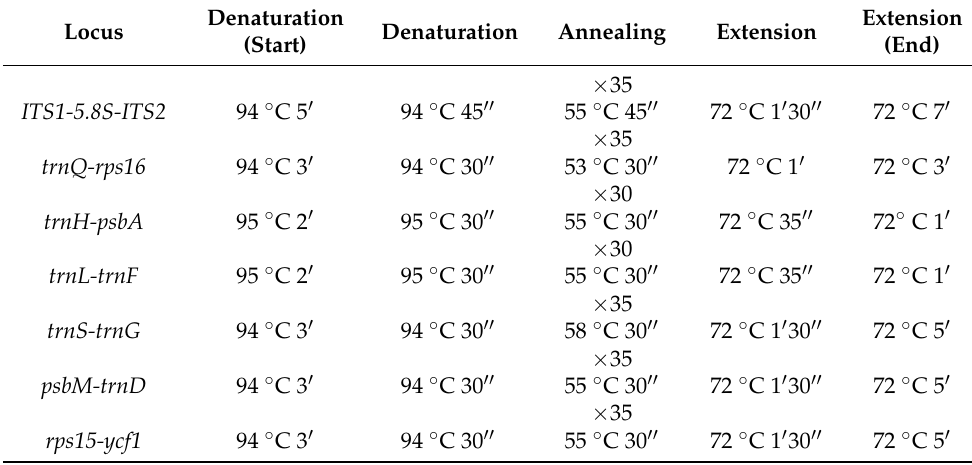
Table 3. Amplification conditions for the studied molecular